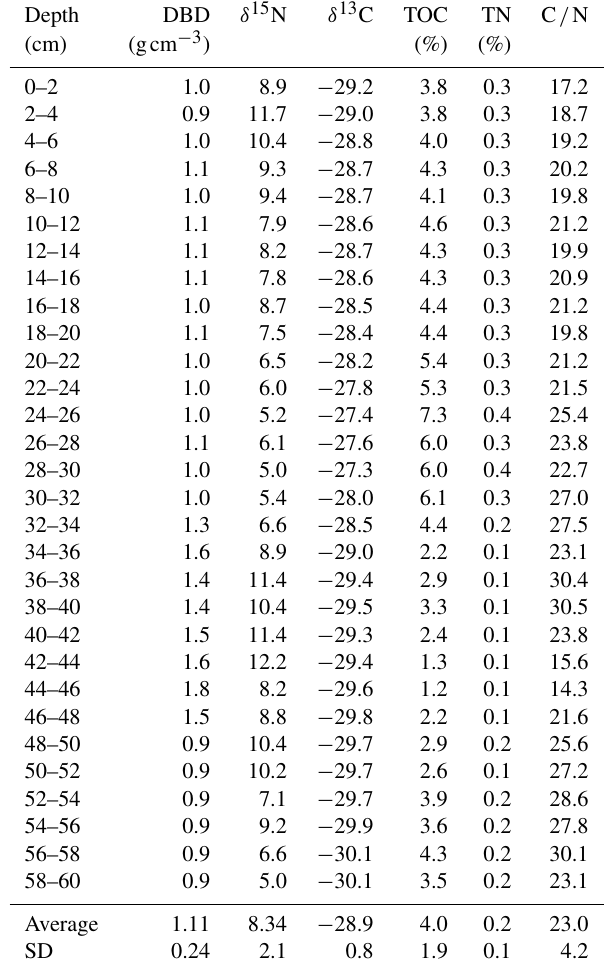
Table 2. Depth profiles of dry bulk density (DBD), total organic carbon (TOC in %), total nitrogen (TN in %), carbon and nitrogen (C / N) molar ratios, δ 13 C and δ 15